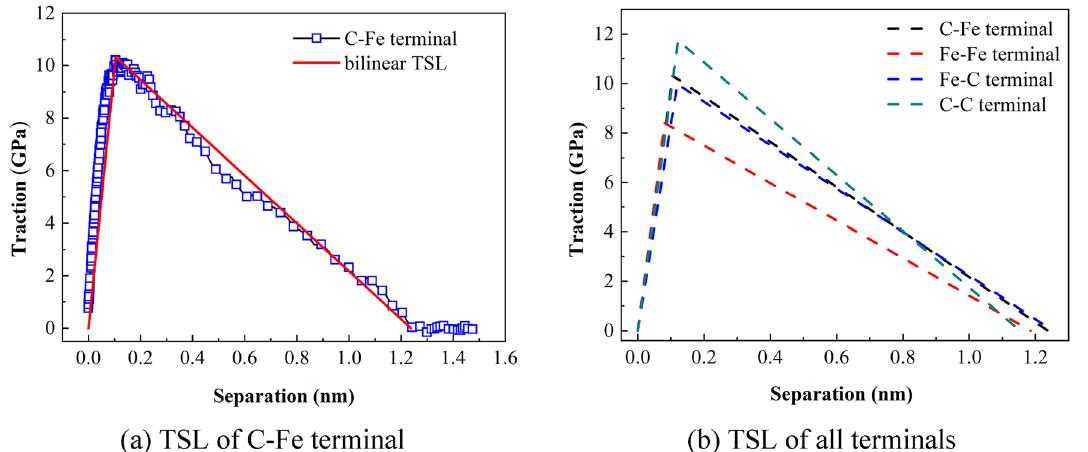
Figure 18. Triangular failure criteria for four terminal type